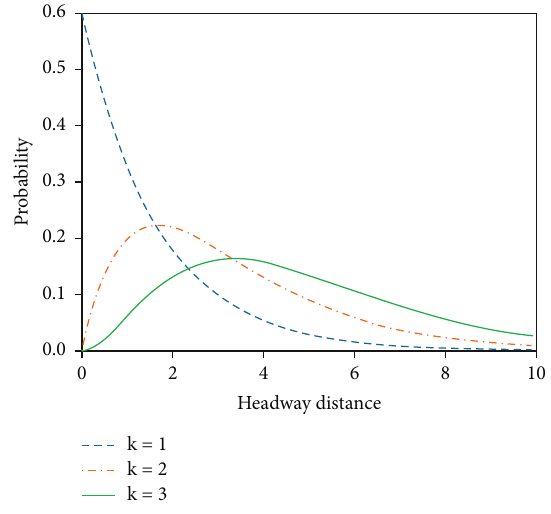
Figure 3: Erlang